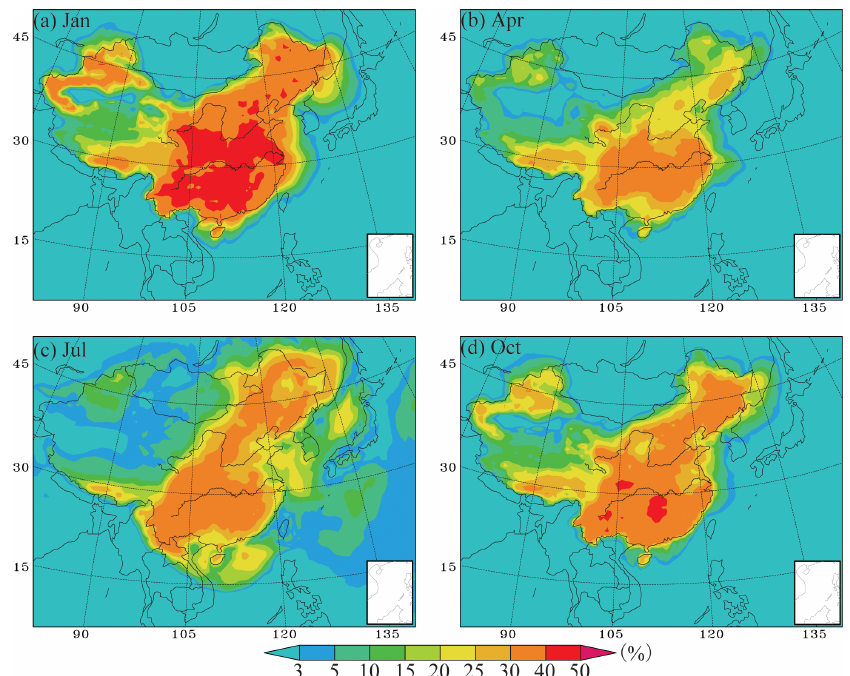
Figure 6. The horizontal distributions of the contribution percentage of NH 3 emissions to SNA mass concentration (%) in January, April, July, and October.